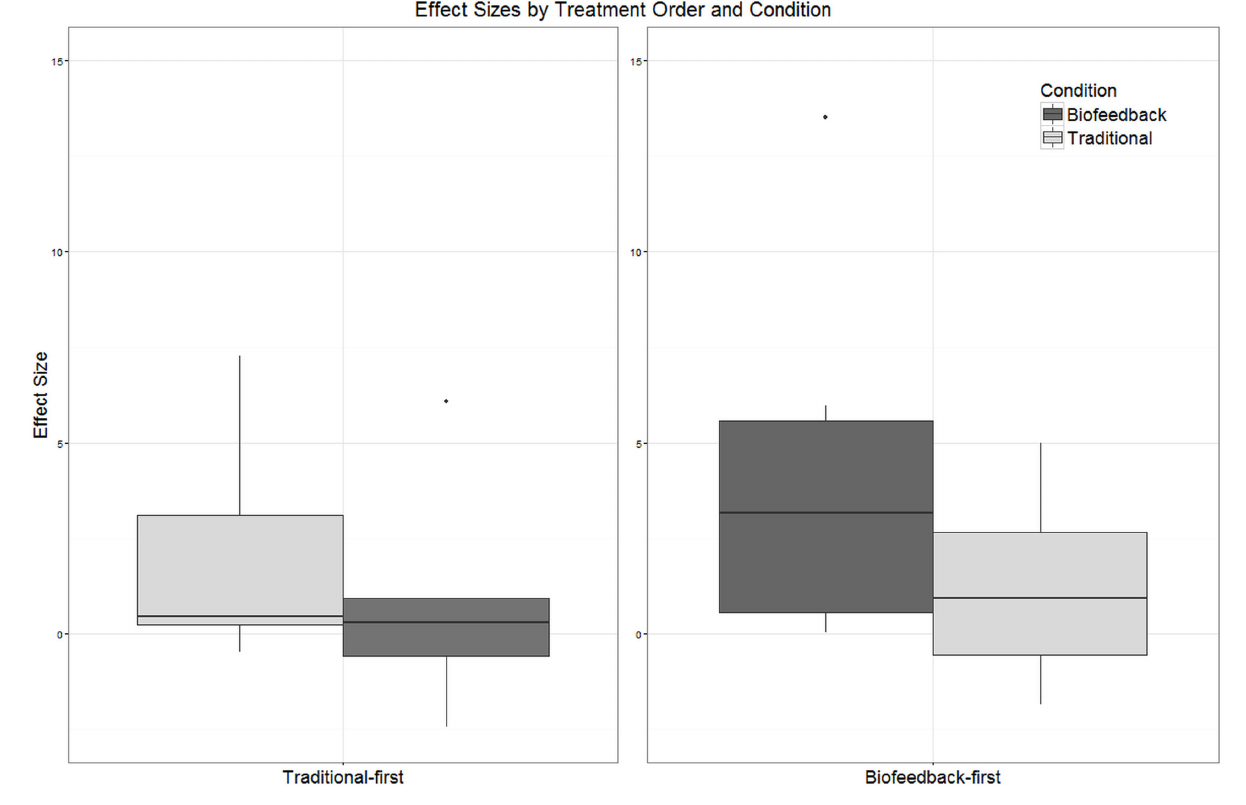
FIGURE 6 | Boxplots depicting the distribution of effect sizes observed in connection with biofeedback versus traditional treatment. Participants have been partitioned into two groups reflecting the order in which treatment was delivered (traditional-first versus